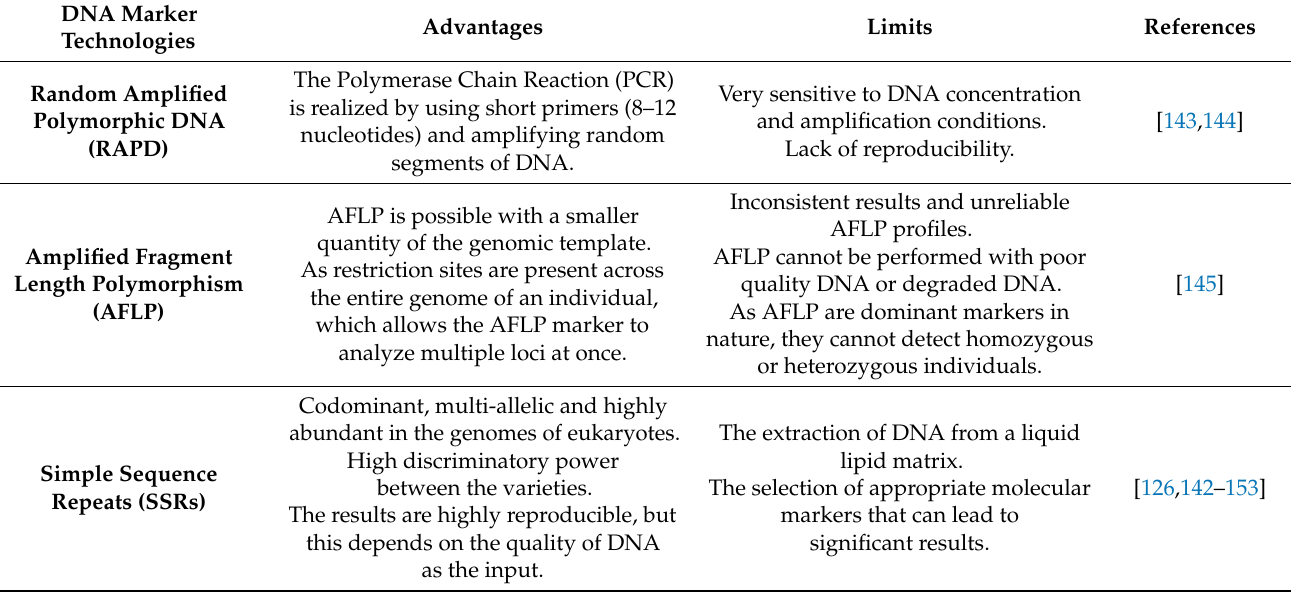
Table 3. The DNA-based technologies for olive oil